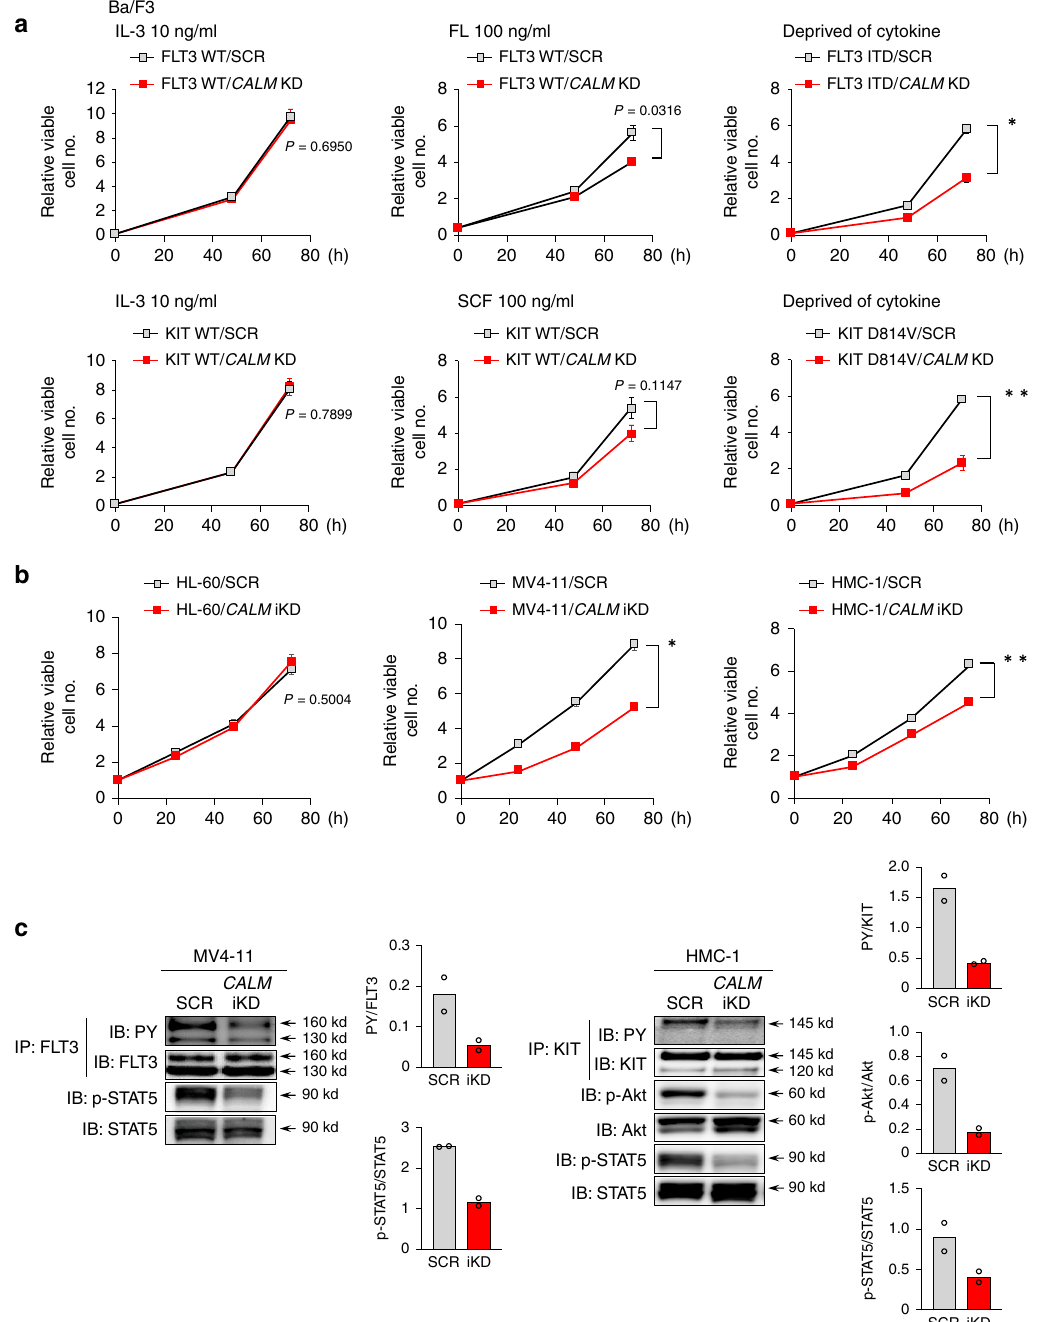
Fig. 1 CALM shRNA severely impairs the growth of hematopoietic cells with MT-RTKs. a CALM was knocked down in Ba/F3-FLT3 WT, Ba/F3-FLT3 ITD, Ba/F3-KIT WT, and Ba/F3-KIT D814V by shRNA speci fi c to CALM ( CALM shRNA) or scrambled (SCR) shRNA as a control. These clones were cultured under various conditions to assess the in fl uences of CALM KD on IL-3-dependent growth (left panel), FL- and SCF-dependent growth (center panel), and FLT3 ITD- and KIT D814V-dependent growth (right panel). The growth of these cells was assessed at the indicated points. Data shown are the mean ± SEM from three independent experiments. Two-sided unpaired Student ’ s t test, * p = 0.0018, ** p = 0.0018. b CALM was knocked down with SCR shRNA as a control in AML cell lines, MV4-11, HMC-1, and HL-60, with a doxycycline (DOX) inducible system. The growth of these cells was monitored until 72 h after the start of DOX treatment. Data shown are the mean ± SEM from three independent experiments. Two-sided unpaired Student ’ s t test, * p = 0.0013, ** p = 0.0003. c Tyrosine-phosphorylated status of FLT3, KIT and their downstream STAT5, and Akt were investigated by immunoprecipitation and/or immunoblot analyses using the indicated cells. Representative images of two independent experiments are shown. Densitometry analysis was carried out by Image Quant TL, and data is from two independent